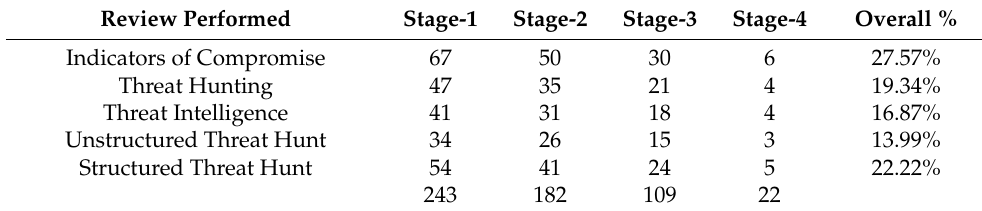
Table 2. Behavior-based threat hunting literature